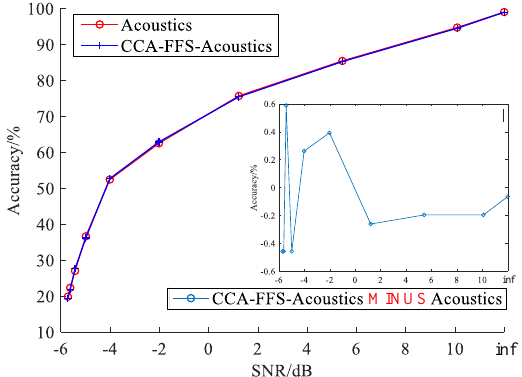
Figure 4. Recognition accuracies of the acoustics